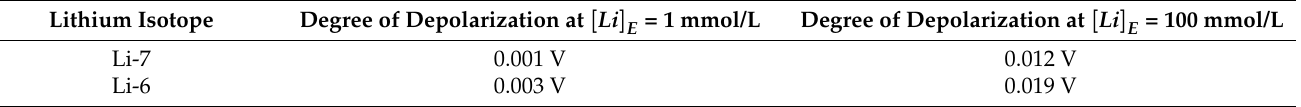
Table 31. The table shows the depolarization degree based on the quantum transport of both isotopes as in graph (c) of Figure